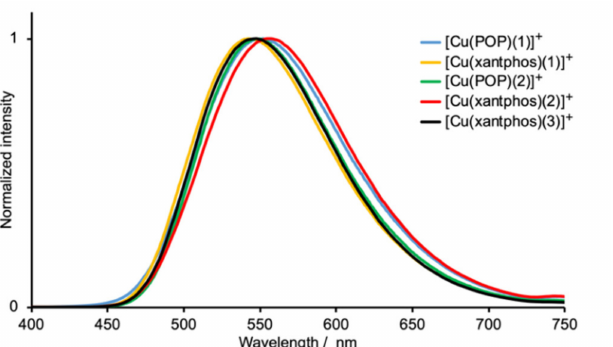
Figure 10. Normalized emission spectra of powdered samples of the heteroleptic copper(I) complexes ( λ exc = 365 nm). Table 4. Emission properties of the [Cu(PˆP)(NˆN)][PF 6 ] compounds in the solid state.